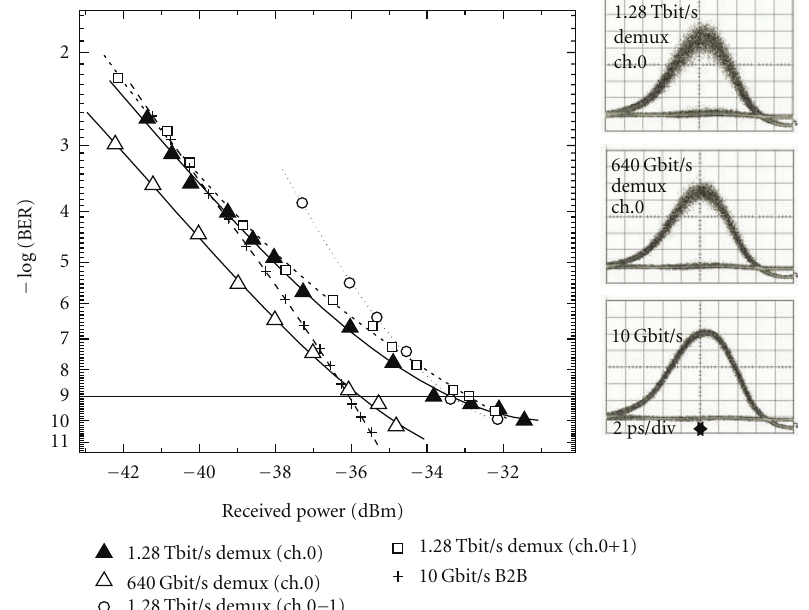
Figure 6: BER results for 1.28 Tbit/s demultiplexing. Left: BER performance showing error-free (BER < 10 − 9 ) performance. Right: demultiplexed eye diagrams for 1.28 Tbit/s (top), 640 Gbit/s (middle), and the 10Gbit/s back to back (bottom).